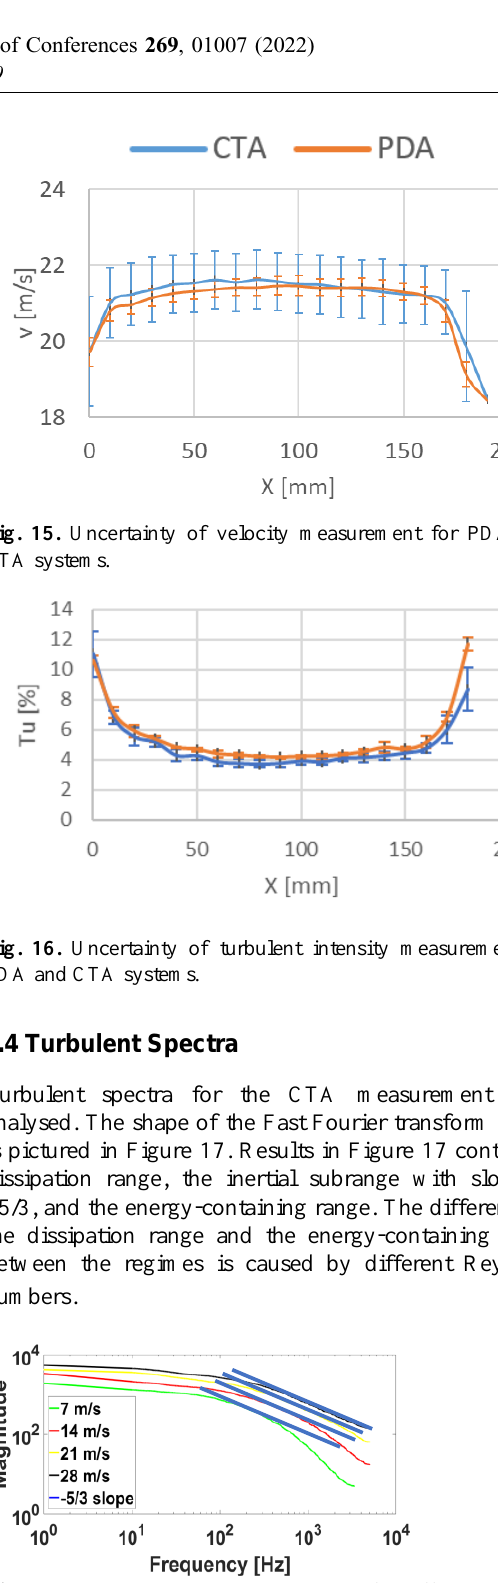
Fig. 17. Results obtained by FFT analysis for different velocity regimes .